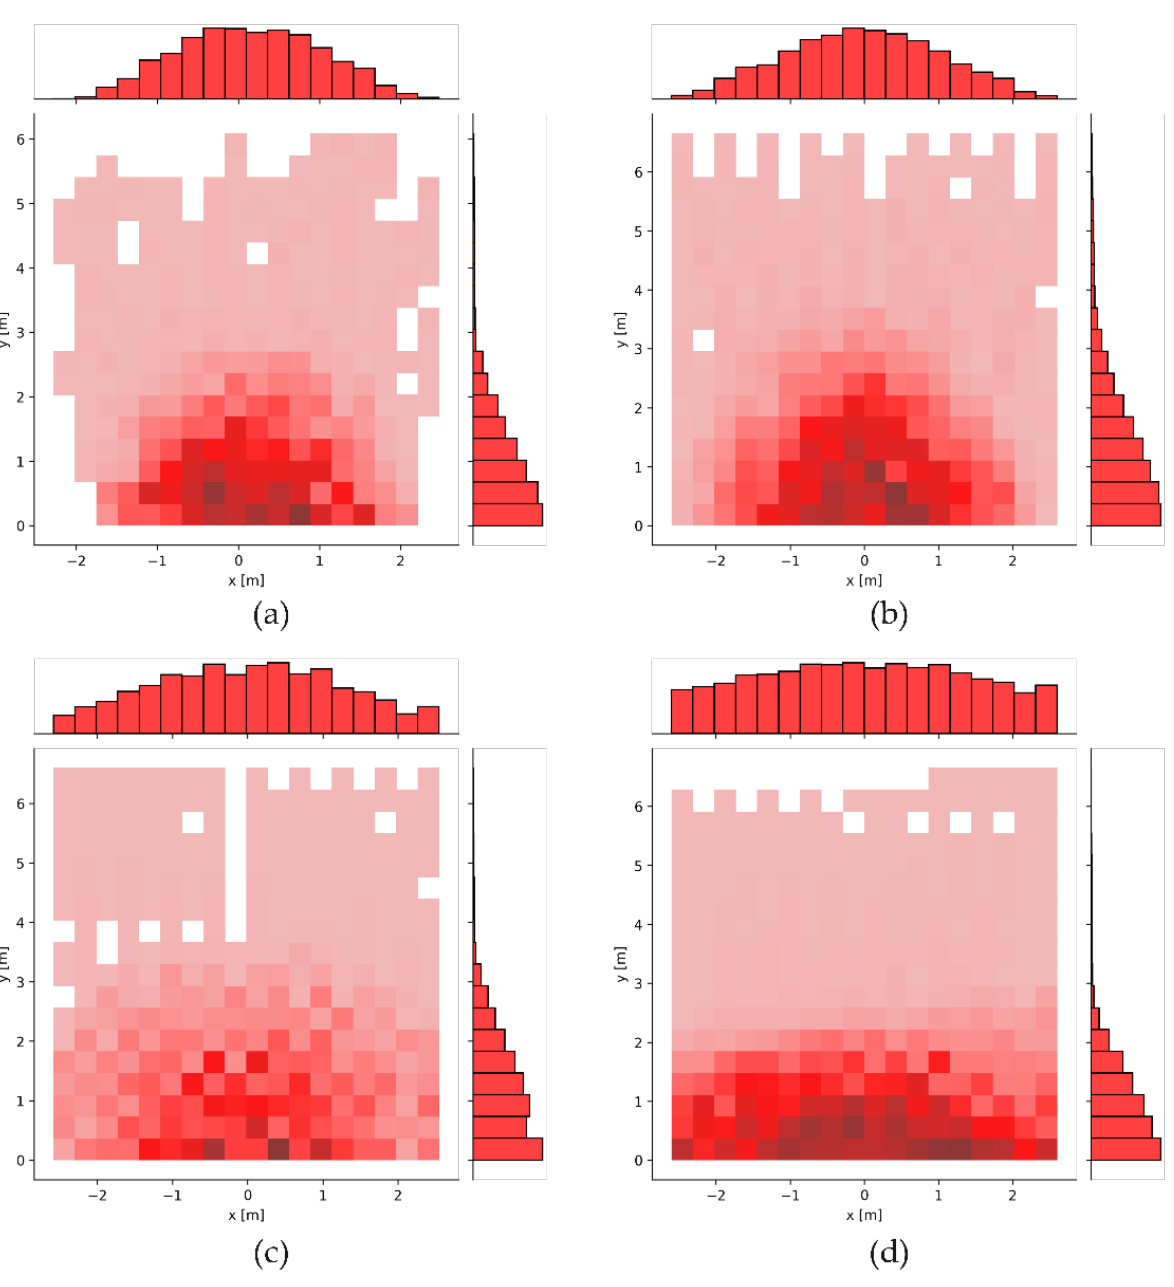
Figure 7. Density maps. ( a ) Density map generated by the real crowd experiment; ( b ) density map generated by HDRLM3D; ( c ) density map generated by SFM; ( d ) density map generated by ORCA.